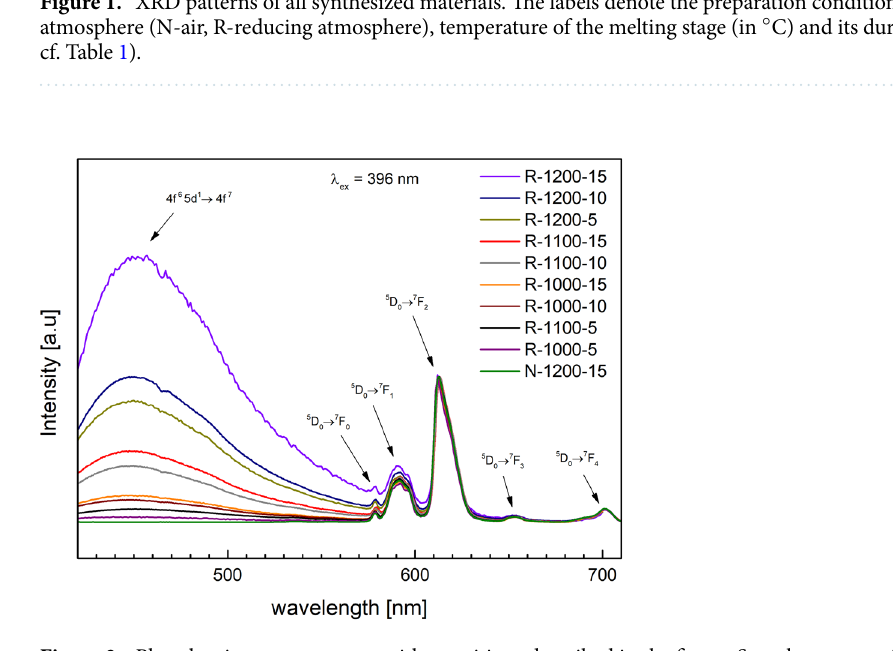
◦ C) and its duration (in min,